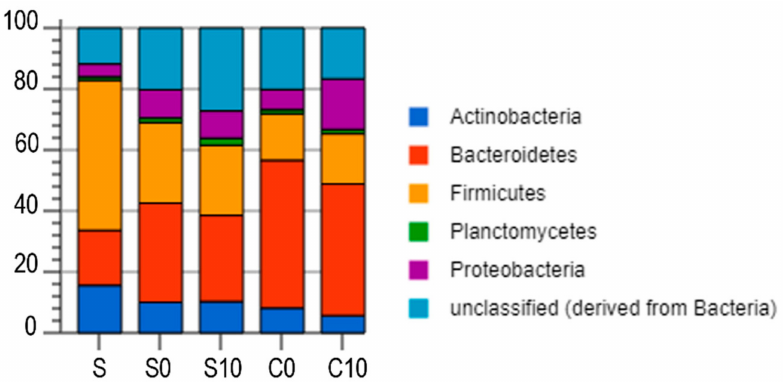
Figure 2. Bacteria phylum relative abundance. Phylum level with relative abundance lower than 1% were included in unclassified group. Sludge from control reactor (S), sludge from reactor with granular activated carbon (GAC) (S0), sludge from reactor with GAC biofilm developed before undertaking the BMP test (S10), GAC biofilm from reactor with GAC (C0), and GAC biofilm from reactor with GAC biofilm developed before undertaking the BMP test